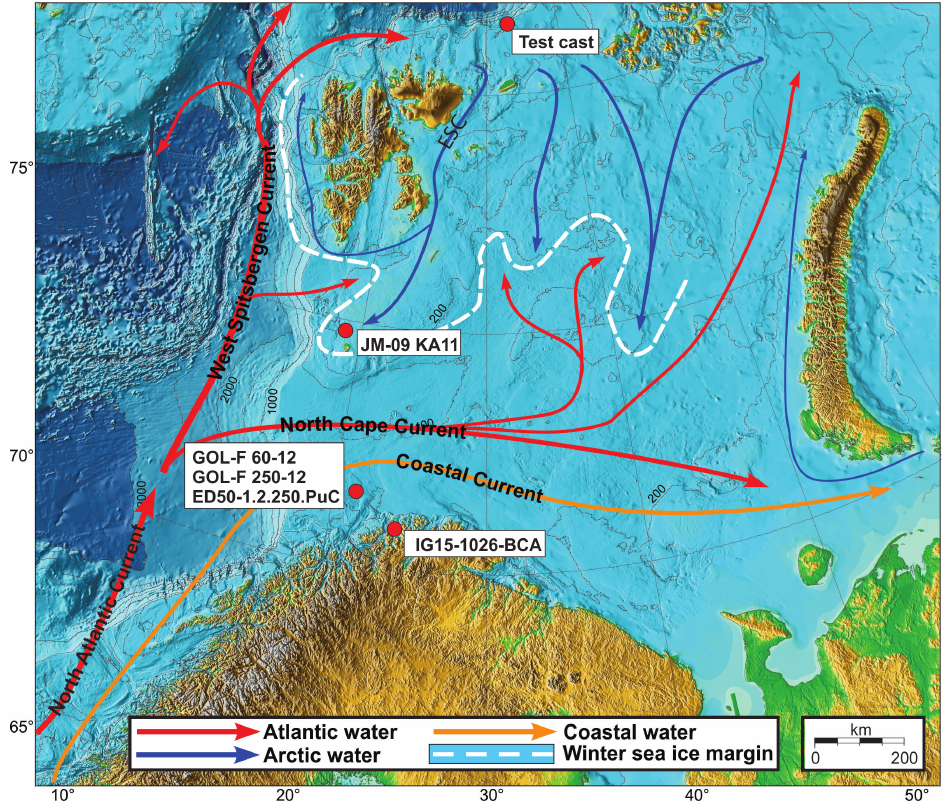
Figure A4. Topographic map of the Barents Sea region with main surface currents and winter sea ice margin. Coring sites marked with red dots. ESC = East Spitsbergen